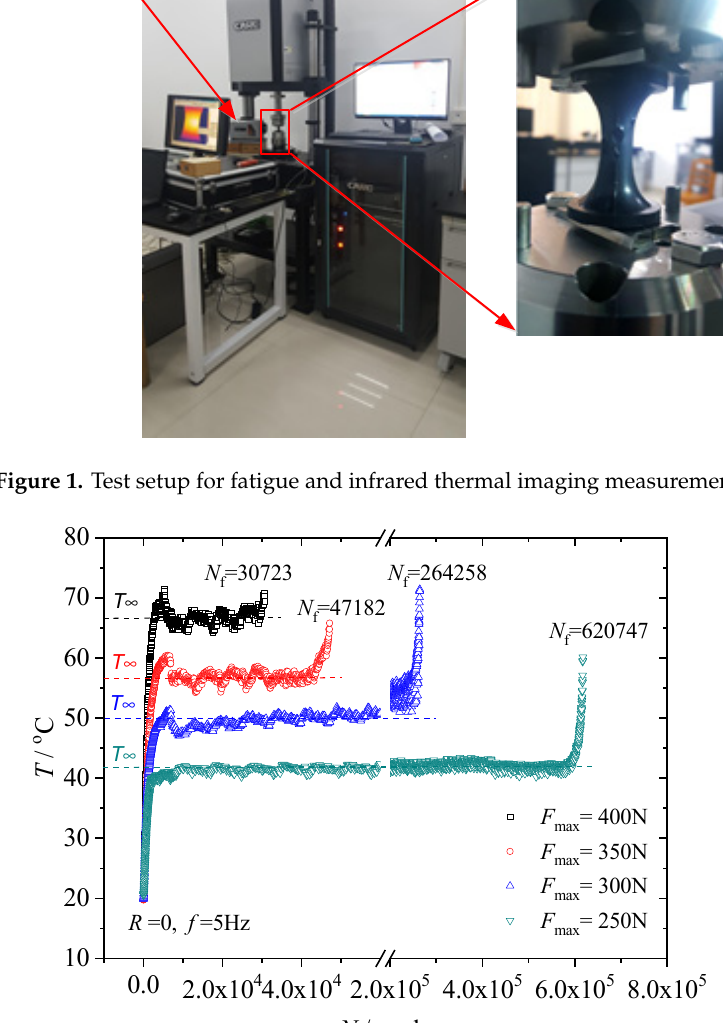
Figure 1. Test setup for fatigue and infrared thermal imaging measurement.